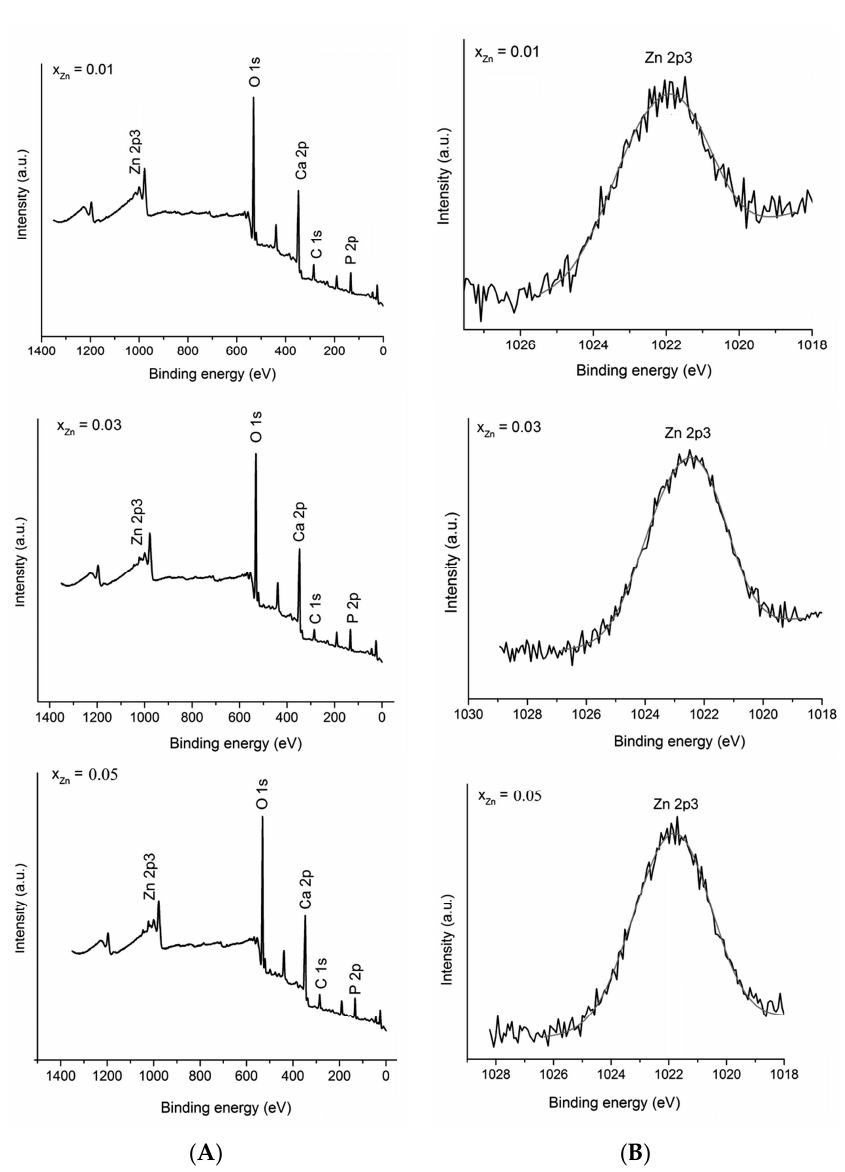
Figure 3. XPS general spectrum of Zn:Hap, Ca 10 − x Zn x (PO 4 ) 6 (OH) 2 samples synthesized with 0.01 ≤ x Zn ≤ 0.05 ( A ); and narrow scan spectra of Zn element ( B ). SEM images and EDAX analysis for the Zn:HAp (0.01 ≤ x Zn ≤ 0.05) samples obtained by